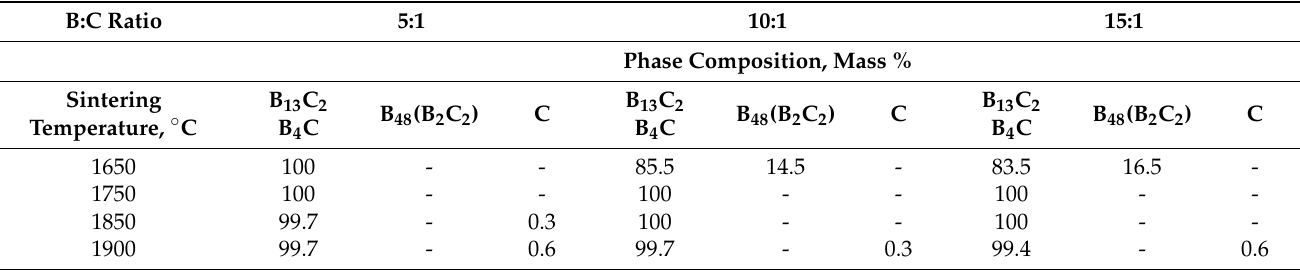
Table 2. Phase composition of samples prepared from mixtures with different B:C mass ratios, as a function of reaction sintering